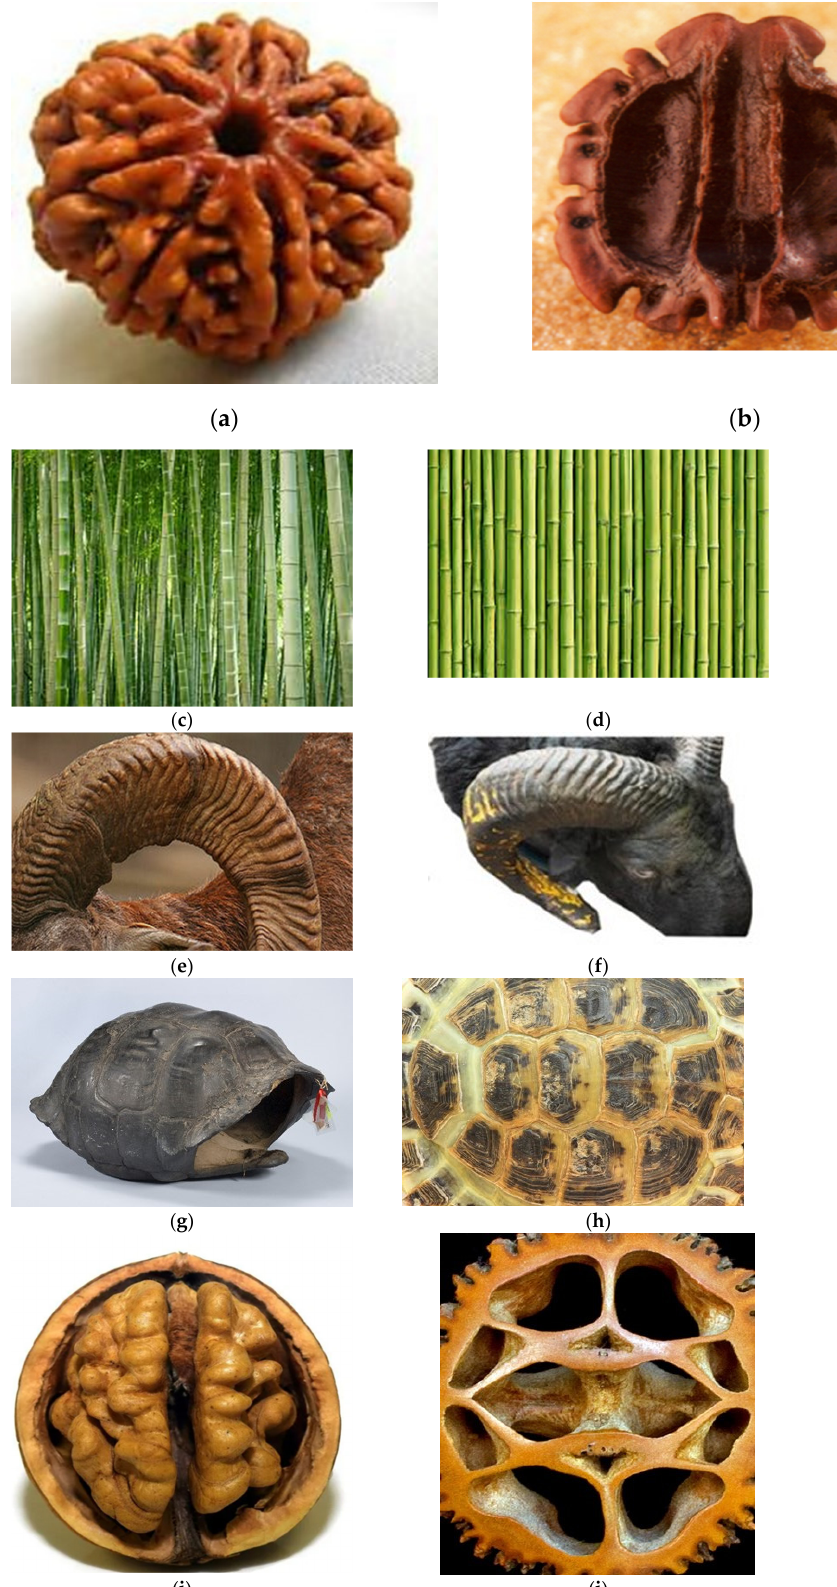
Figure 2. Bio-inspired patterns; ( a ) Rudraksha; ( b ) Rudraksha cross-section; ( c ) Bambusa tulda ; ( d ) Bambusa tulda front view; ( e ) sheep horn outer scale; ( f ) sheep horn outer scale; ( g ) tortoiseshell; ( h )